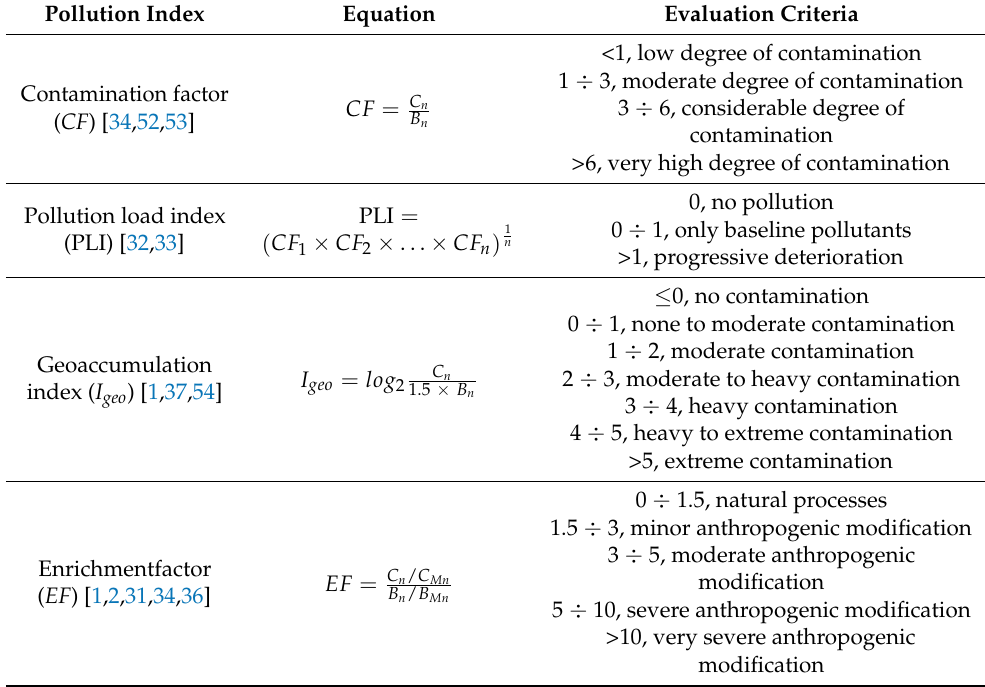
Table 1. Sediment pollution indices and evaluation criteria for potential contamination